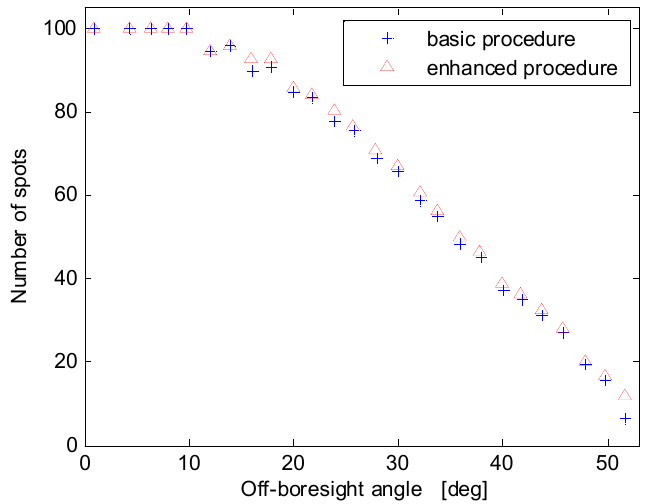
Figure 7. Average number of acquired sun spots versus the off-boresight angle for the basic and enhanced